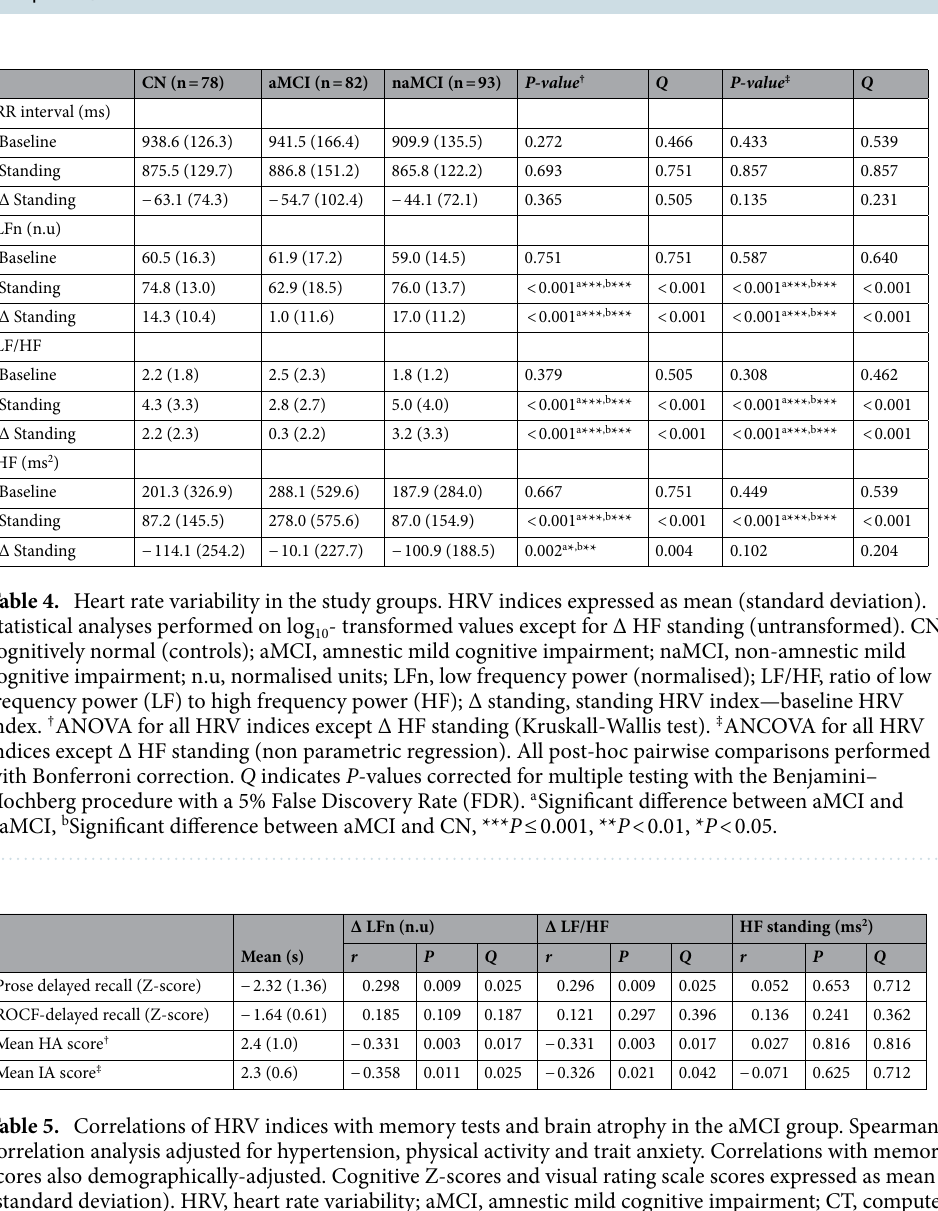
correlation with the other episodic memory test (Rey-Osterrieth Complex Figure (ROCF)-delayed recall) appears consistent with research on AD-related cognitive impairment, demonstrating earlier involvement of verbal than visual memory 26,27 . As far as we aware, the specific association between episodic memory and HRV indices has not been previously highlighted in aMCI subjects. Nonetheless, memory recall has been found to correlate with parasympathetic HRV (negatively) in a mixed MCI-AD/MCI-LBD sample 19 , and with HRV indices of sympa- thetic activation/parasympathetic withdrawal (positively) in an older cohort 13 . Also, a negative relationship has been reported in late life depression 78 between the quality of episodic memory and TP at rest (which can be considered a mainly parasympathetic index) 9 .